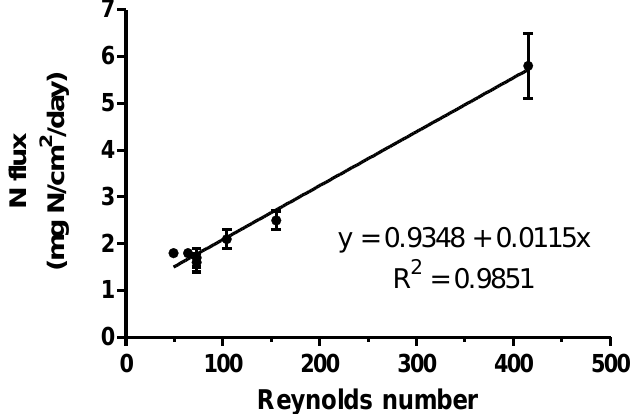
Figure 6. Ammonia flux (mg N per cm 2 of membrane surface per day) through the gas-permeable membrane as affected by changes in Reynolds number (combined data from experiments 1 and 2). Data points are means ± s.d. of duplicate experiments.